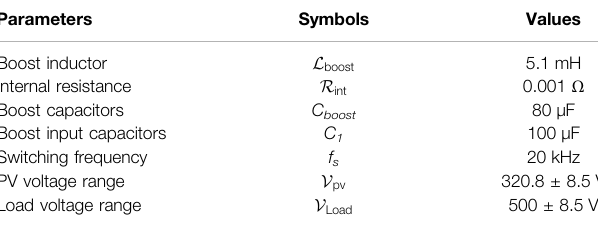
TABLE 2 | The speci fi cation of electrical parameters for the boost converter. Parameters Symbols